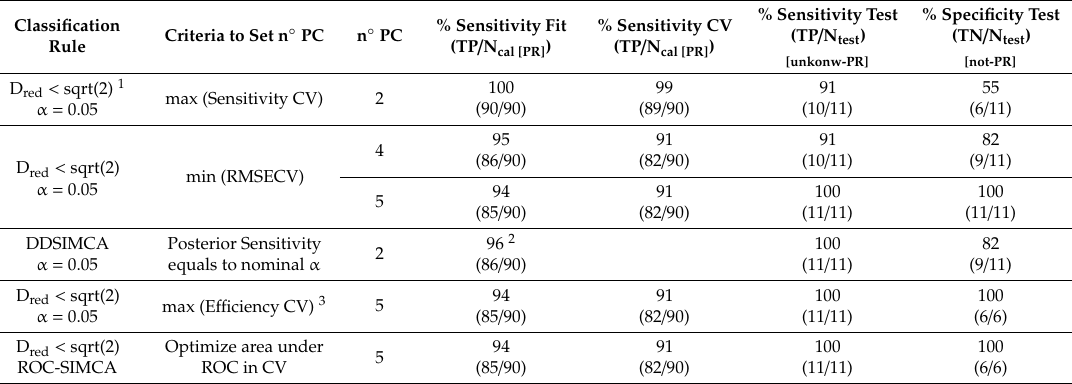
Figure 3. One-class Soft Independent Modeling of Class Analogy (SIMCA) model built using authentic PR samples (PR1st and PR2nd, in Table 1) as a calibration set. ( a ) Sensitivity, specificity and e ffi ciency in CV vs. number of components. Specificity was estimated on five not-PR samples. ( b ) Sensitivity in CV (red line, right y -axis) and RMSECV (blue line, left y -axis) vs. number of components. The shaded areas in each graph highlights the number of components selected according to each one of the criteria, Sensitivity_CV (red shade), E ffi ciency_CV (green shade) and RMSECV (blue shade), respectively. Sensitivity in ( a ) and ( b ) are the same. Table 2. SIMCA results (TP = true positive; TN = true